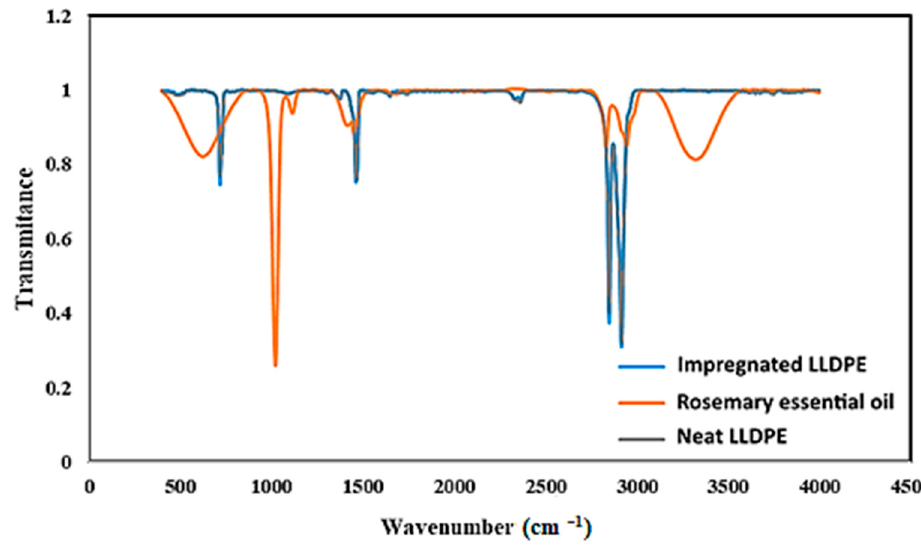
Figure 7. FTIR spectrum of the neat LLDPE, extracted oil from rosemary, and impregnated LLDPE